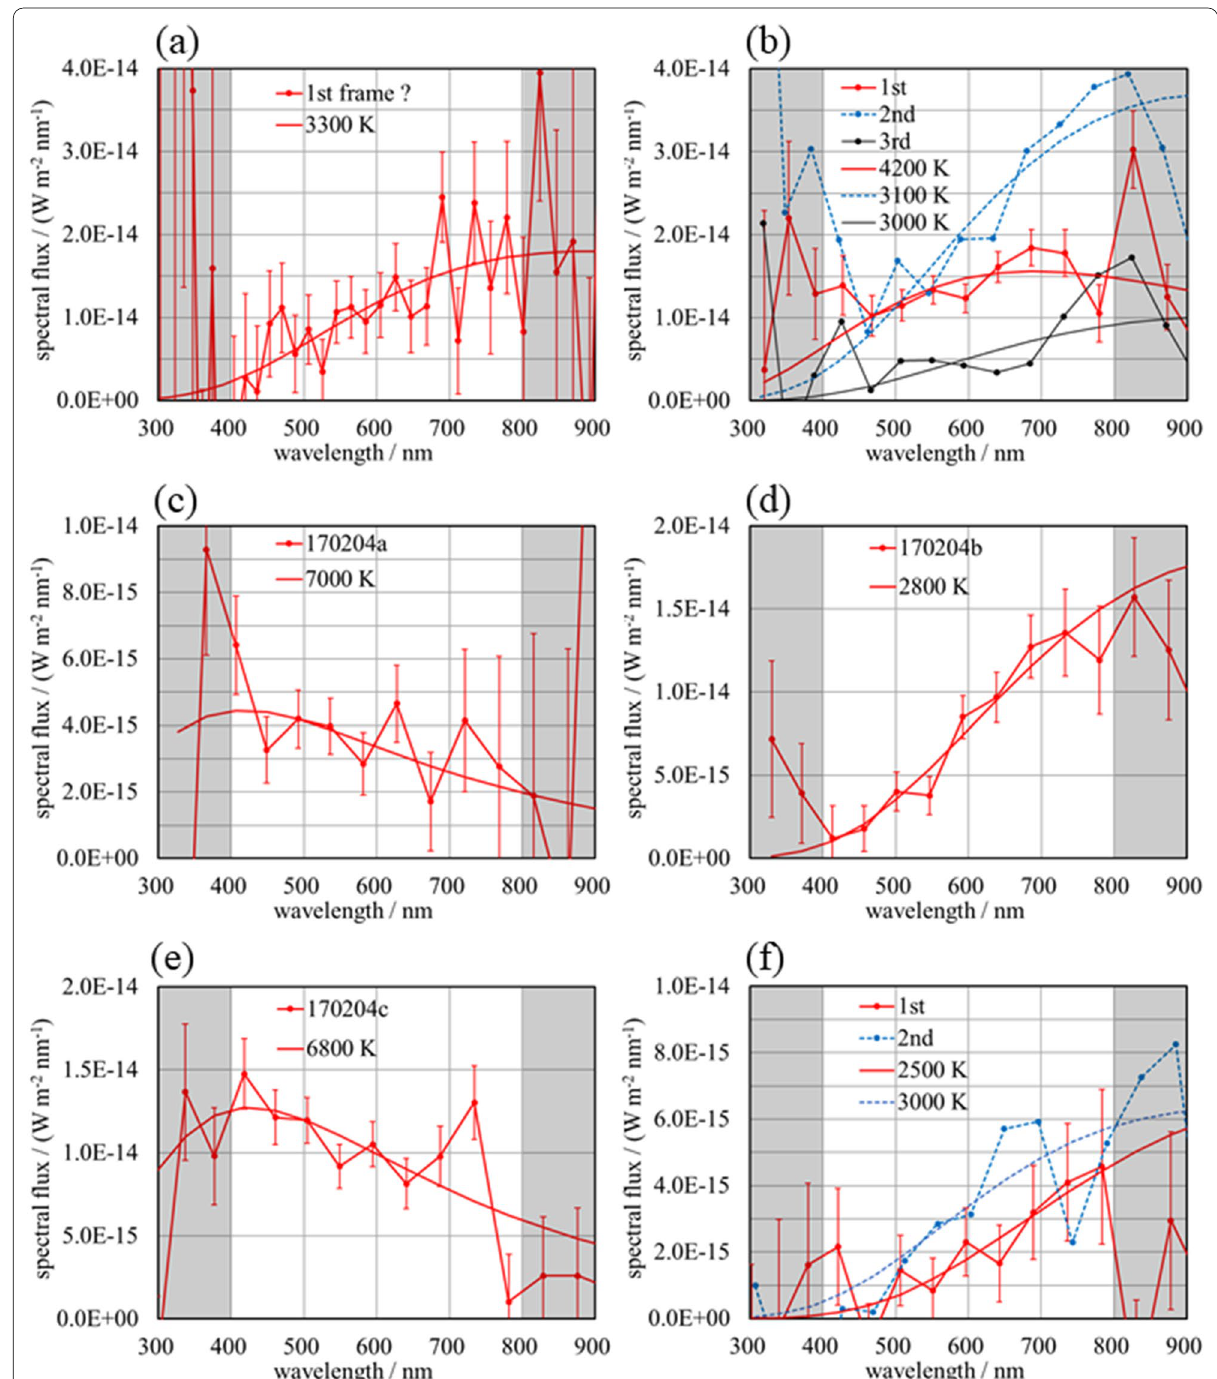
Fig. 15 Spectra of the flashes. Flash name is shown in each panel where only a single frame is bright enough to analyze. For the others: a 161107, b 170201, and f 170204d. Red solid polygonal lines show the spectra for the frames where the flashes first appeared. The blue broken polygonal lines and a black thin polygonal line show the spectra at the 2nd- and 3rd-frames, respectively. Error bars represent one standard deviation of the background fluctuation. We do not show error bars for the 2nd- and 3rd-frames, but they are almost identical to those in the 1st-frame. The fluxes are reliable between 400 and 800 nm in wavelength (the non-shaded area). Blackbody spectra were best fitted to the plots in the non-shaded area and are shown by smooth curves. We show the blackbody temperatures in each panel. The exposure times are equal to the frame intervals and are listed in Table